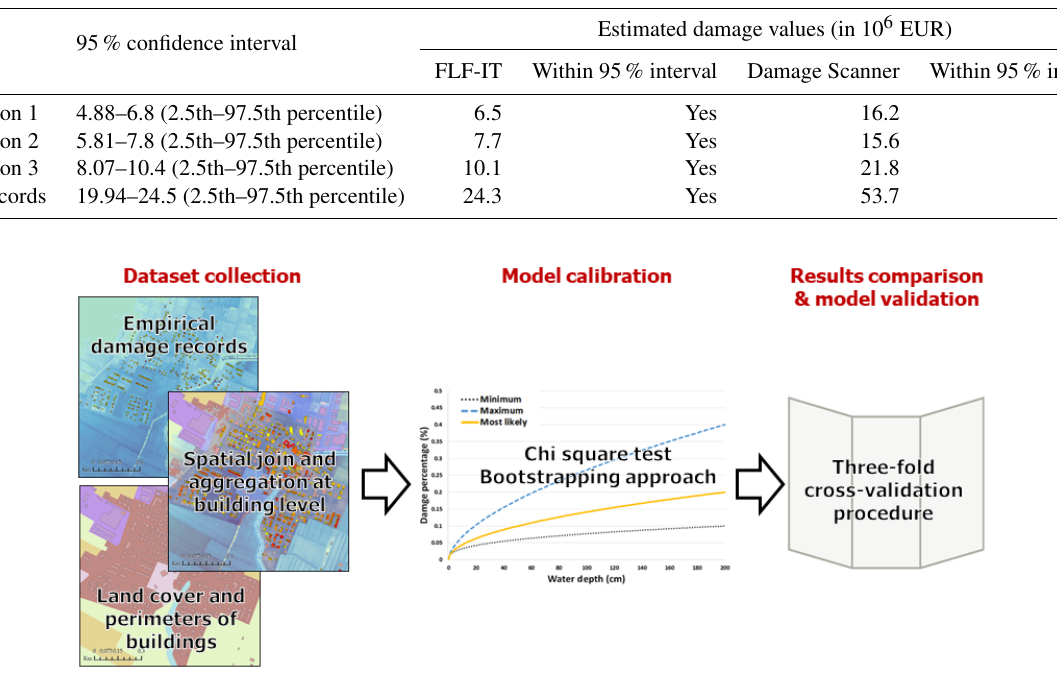
Figure 7. Visualization of the workflow and the methodological steps of the